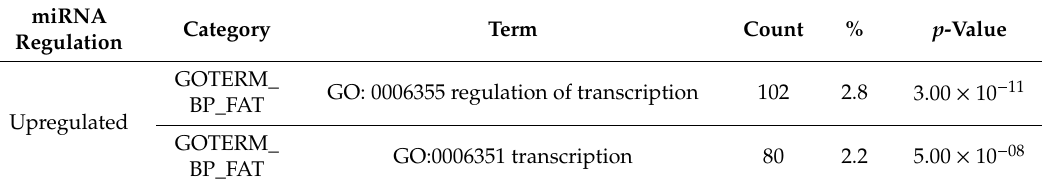
Table 3. Gene ontology (GO) analysis of di ff erentially expressed genes (DEGs) of dysregulated miRNAs. miRNA Category Term Regulation